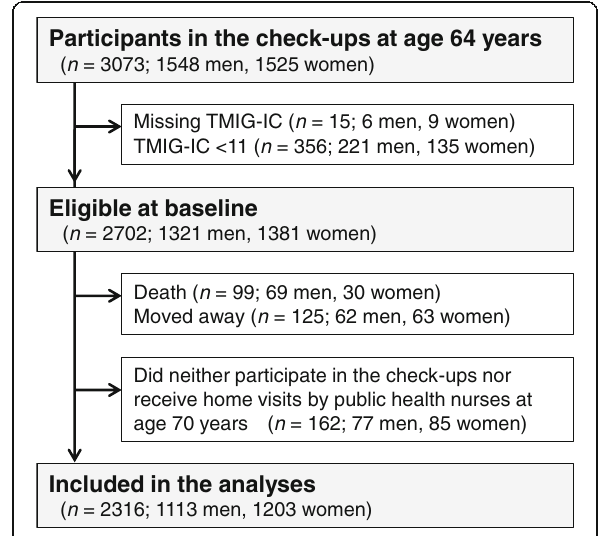
Fig. 1 The flow of the study